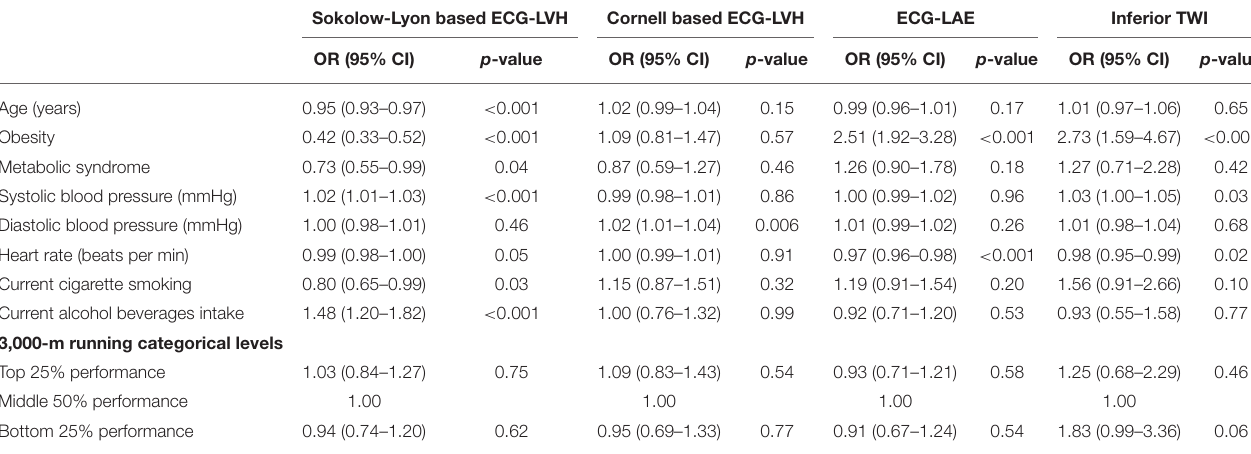
TABLE 5 | Associations between cardiometabolic risk factors and ECG-LVH, ECG-LAE and Inferior TWI. Sokolow-Lyon based ECG-LVH Cornell based ECG-LVH